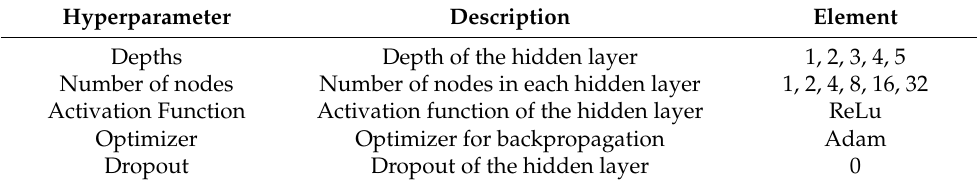
Figure 9. Process of preprocessing the password list and example (red box): ( a ) password list; ( b ) password matrix; ( c ) classification of data. Table 4. Hyperparameter list.